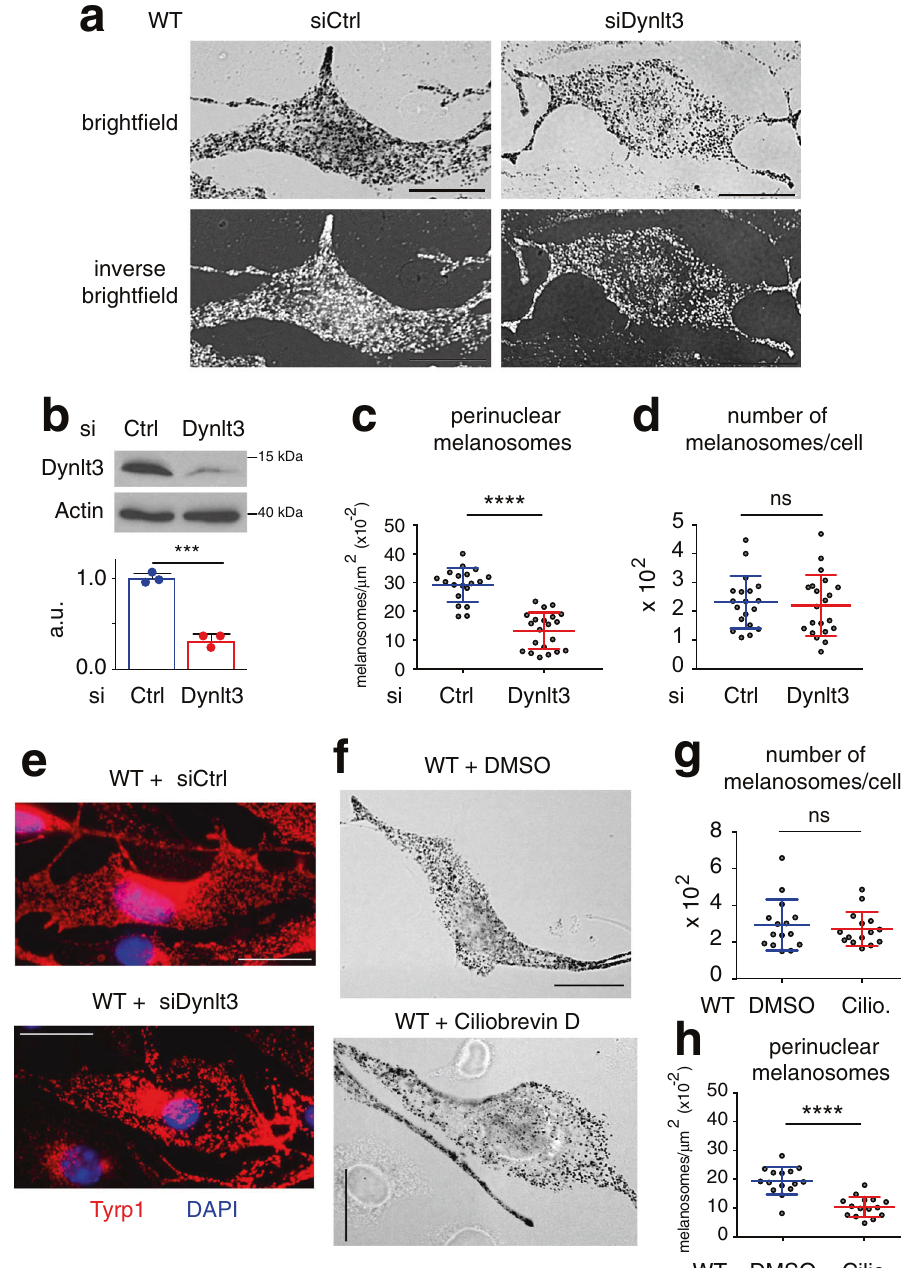
active β -catenin both leads to a signi fi cant increase of directional